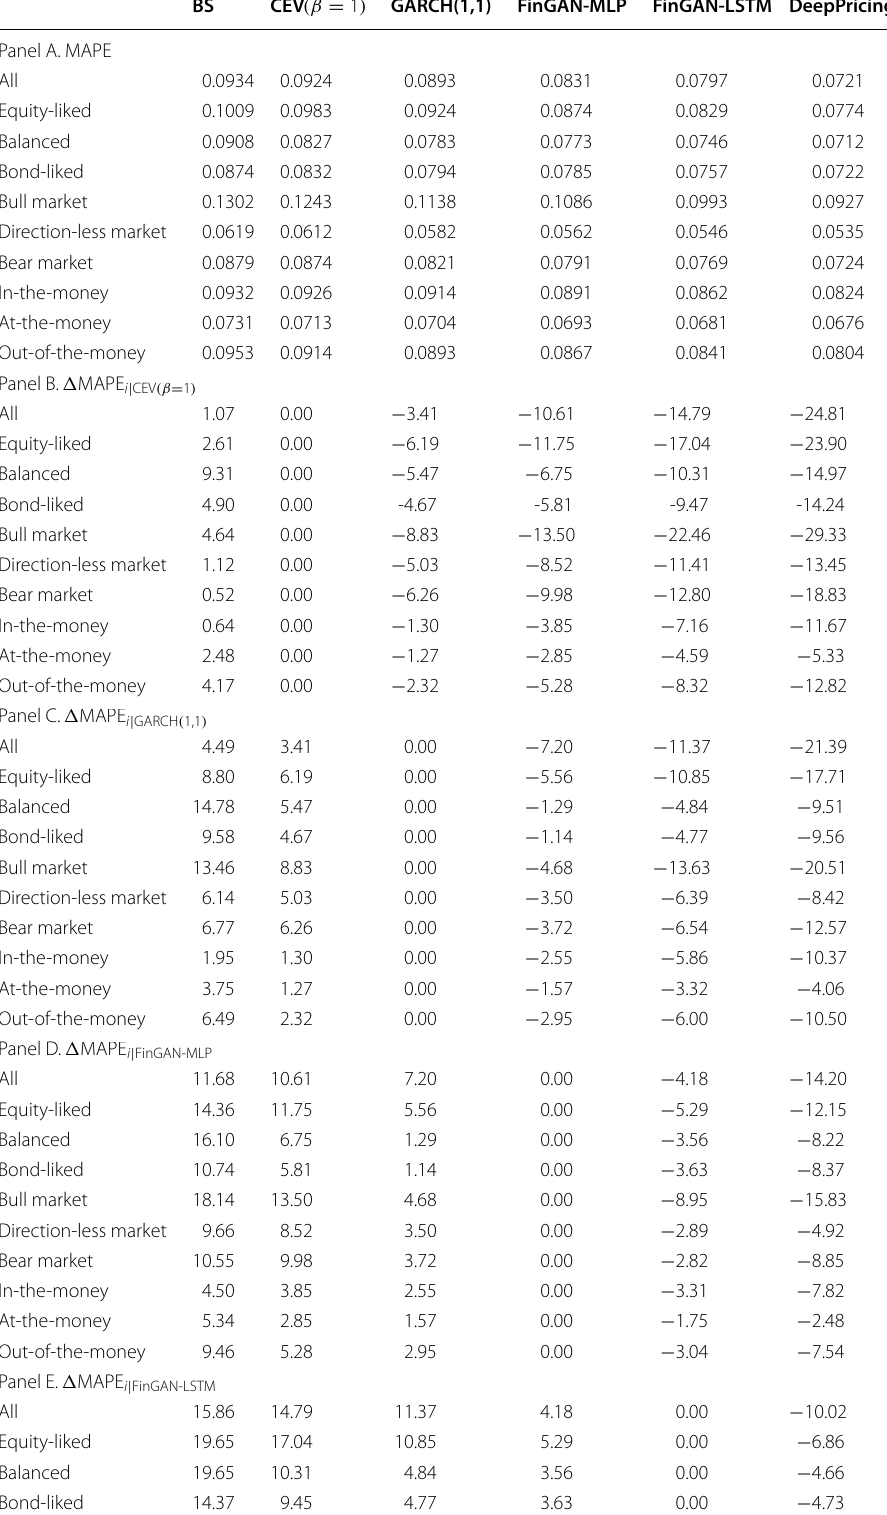
Table 4 Pricing performance across different models: